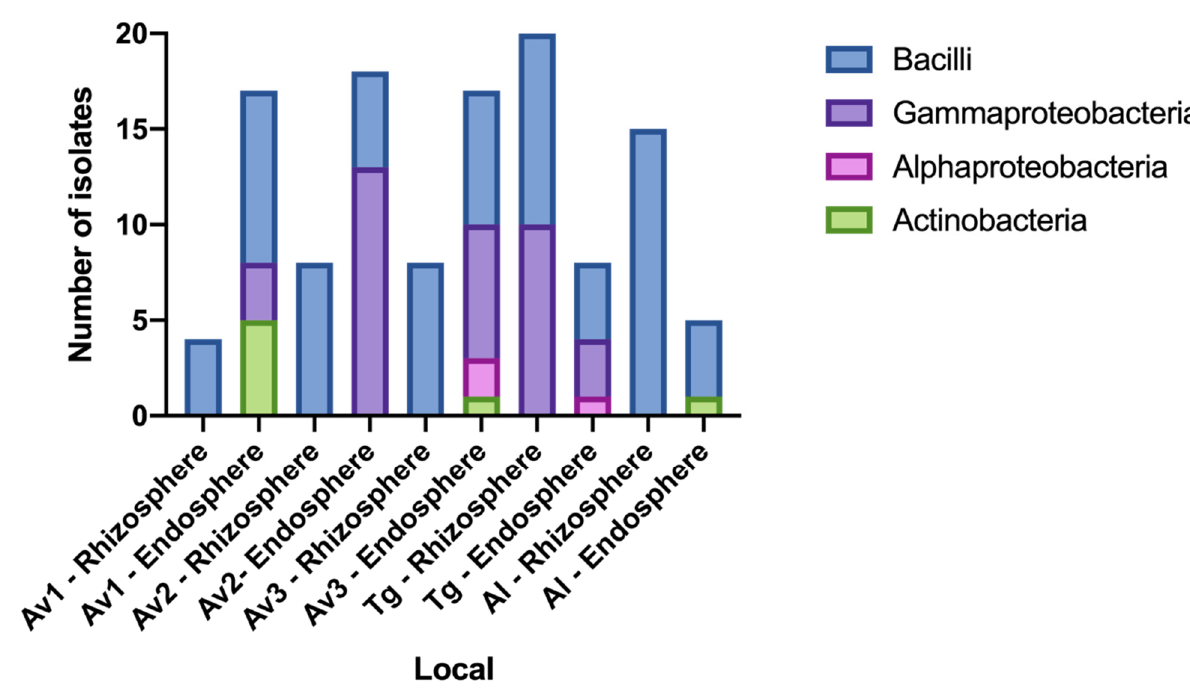
Figure A3. Distribution of the taxonomic affiliation among the collected sites and isolation source (rhizosphere and endosphere) by class level.